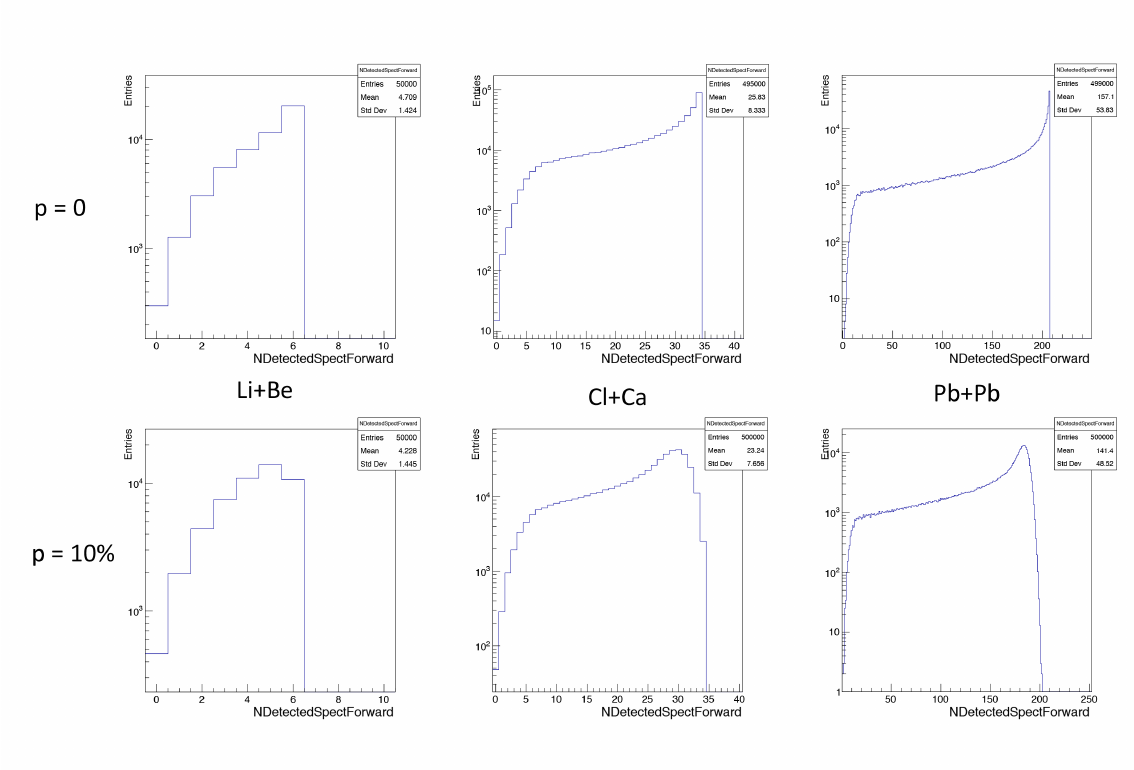
Figure 4. Detected forward spectators distributions for Li + Be, Cl + Ca and Pb + Pb in WNM with a probability to loss a nucleon of 0% and 10%.